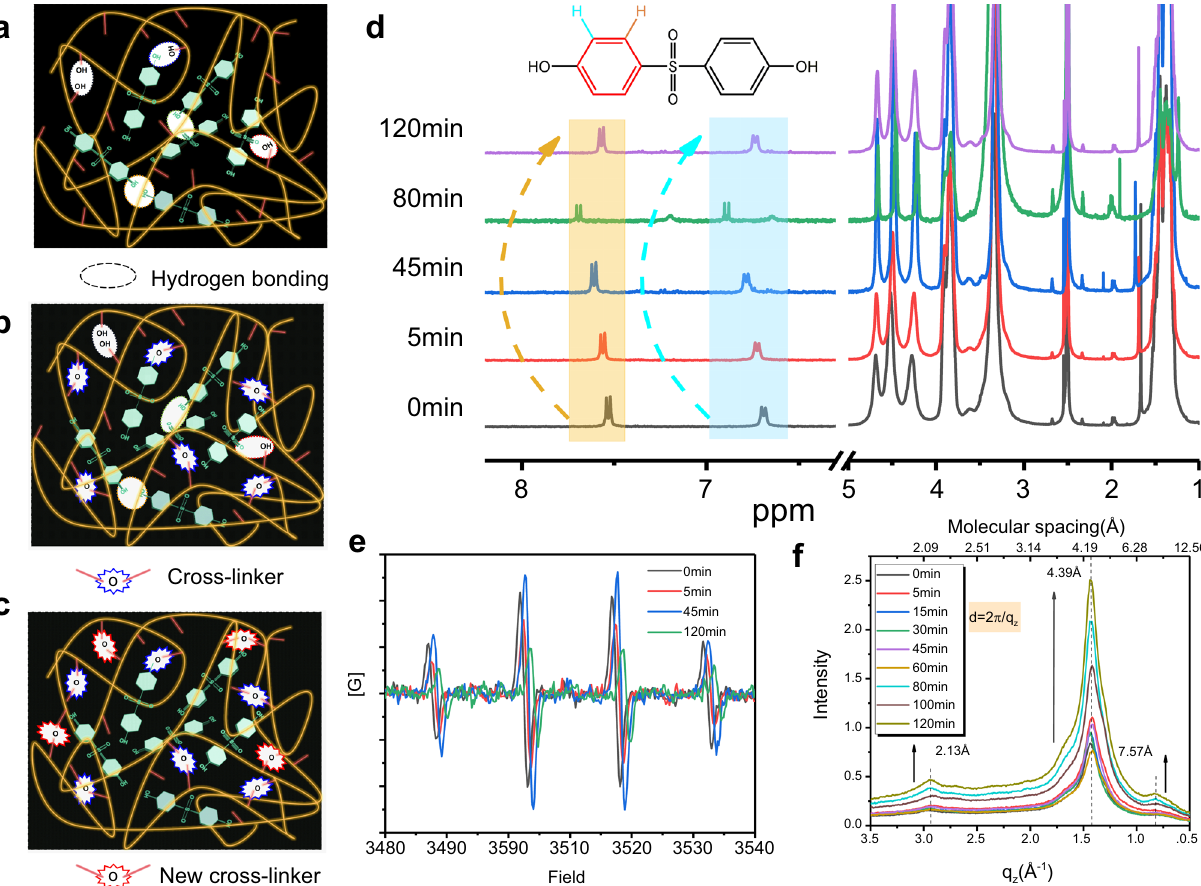
Fig. 4 Mechanism of IRRTP at room temperature. a Hydrogen bonding interactions between SDP and SDP, SDP and PVA, and PVA and PVA in unirradiated SDP-based fi lm. b Covalent bond (C – O – C) formation between PVA chains after 254 nm UV light irradiation for <45 min. c Rearrangement of hydrogen bonding interactions, and further formation of covalent bond (C – O – C) after irradiation for more than 45 min. d 1 H NMR spectra of SDP-based fi lm (1 mg/mL) in DMSO-d 6 recorded after different irradiation times. e Electron paramagnetic resonance spectra and f one-dimentional scattering pro in the q z direction of GiWAXS pattern for SDP-based fi lm (0.3 mg/mL) recorded after different irradiation